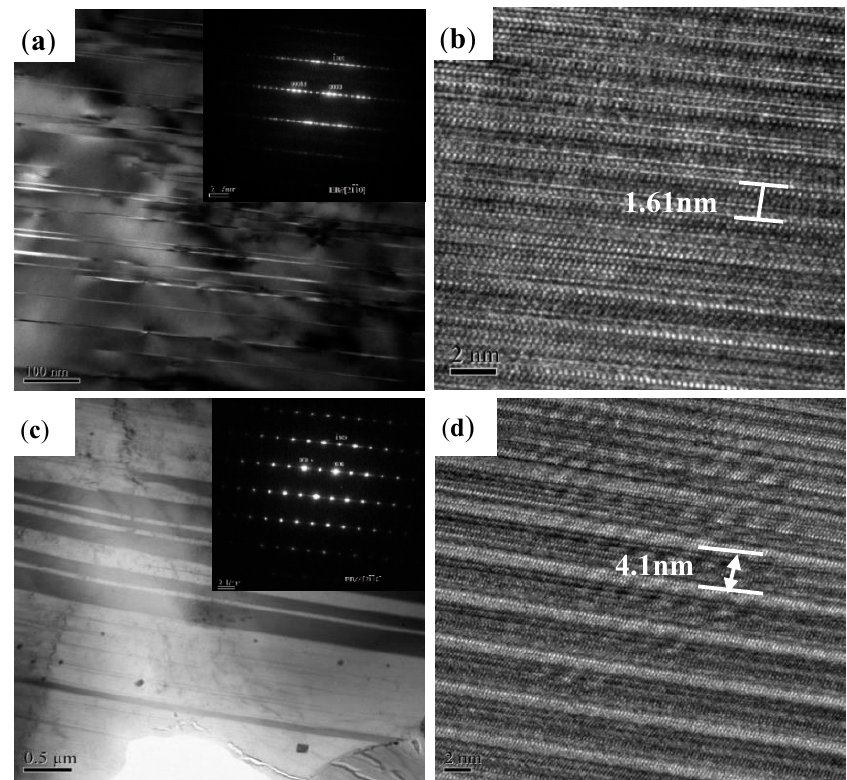
Figure 4. Bright-field transmission electron microscope (TEM) image of ( a ) block LPSO and ( c ) rod LPSO with corresponding selected area electron diffraction (SAED) patterns in the insets, respectively; ( b , d ) high-resolution electron microscope images ( a , c ) in Mg 95.33 Zn 2 Y 2.67 alloy, respectively.